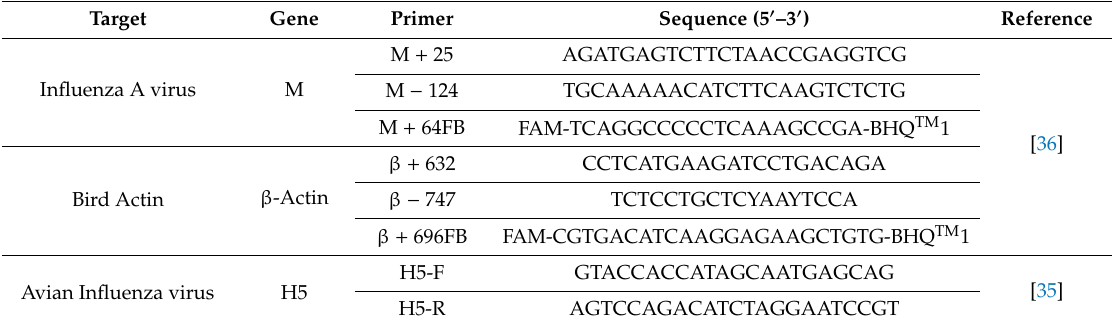
Table 1. Detailed primer sets and probes sequences used in RRT-PCR and